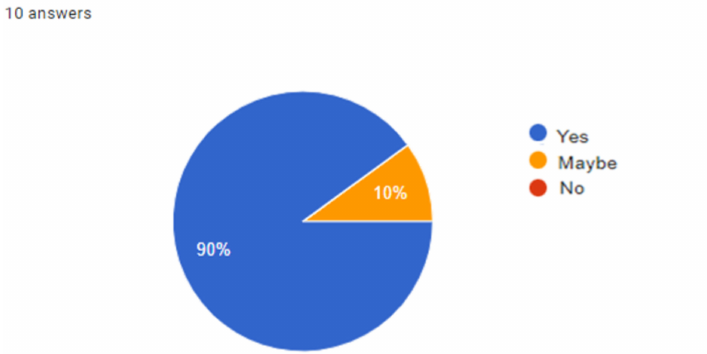
Figure 9. Promotion of the model (NPS) to the worker.